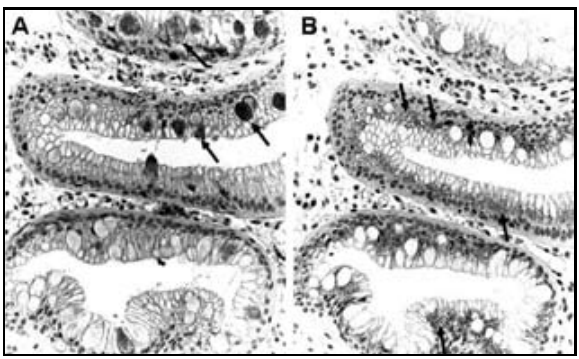
Figura – Expressão imuno-histoquímica de antígenos de carboidratos simples de mucinas no esôfago de Barrett. A: expressão de sTn nas células caliciformes